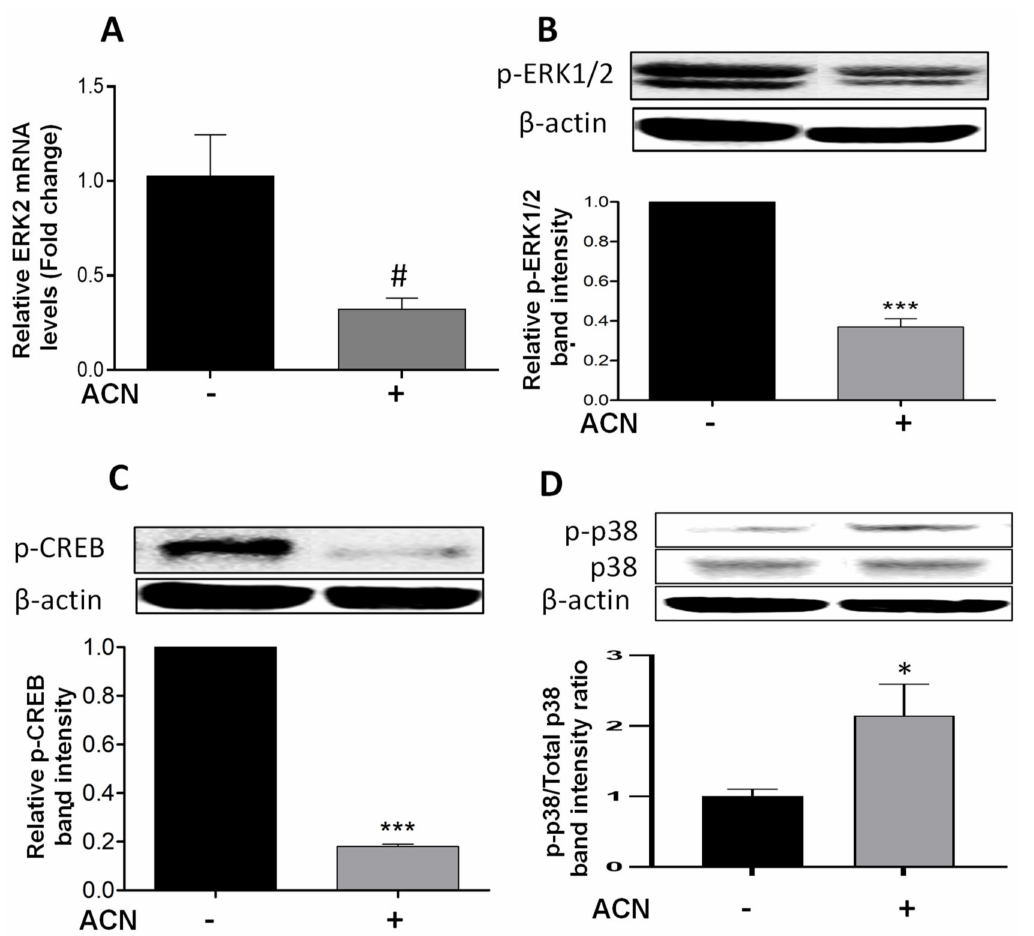
Figure 3. ACN downregulated ERK and its target CREB and induced the phosphorylation of stress- related p38. mRNA levels of ERK2 ( A ). Protein levels of p-ERK1/2 ( B ), p-CREB ( C ), and p-p38 and total p38 ( D ). The ERK2 mRNA levels were determined after 24 h treatment with ACN (IC 50 ). Protein levels of p-ERK1/2 and p-CREB were determined after 48 h treatment with ACN. Protein levels of p-p38 and total p38 were determined after 24 h ACN treatment. Cells starved overnight were treated with ACN (IC 50 ) in 2.5% FBS supplemented culture. Cell lysates were subjected to immunoblot analysis with primary and secondary antibodies as detailed in materials and methods. Western blots are representative of at least two independent experiments (upper panels). Band intensities of target proteins determined with ImageJ software were divided by band intensity of β -actin, and values were normalized to untreated control (lower panels). Data from relative band intensity are mean ± SEM. The unpaired t test with Welch’s correction was used to determine significance (*** p < 0.001; * p < 0.05, # p =